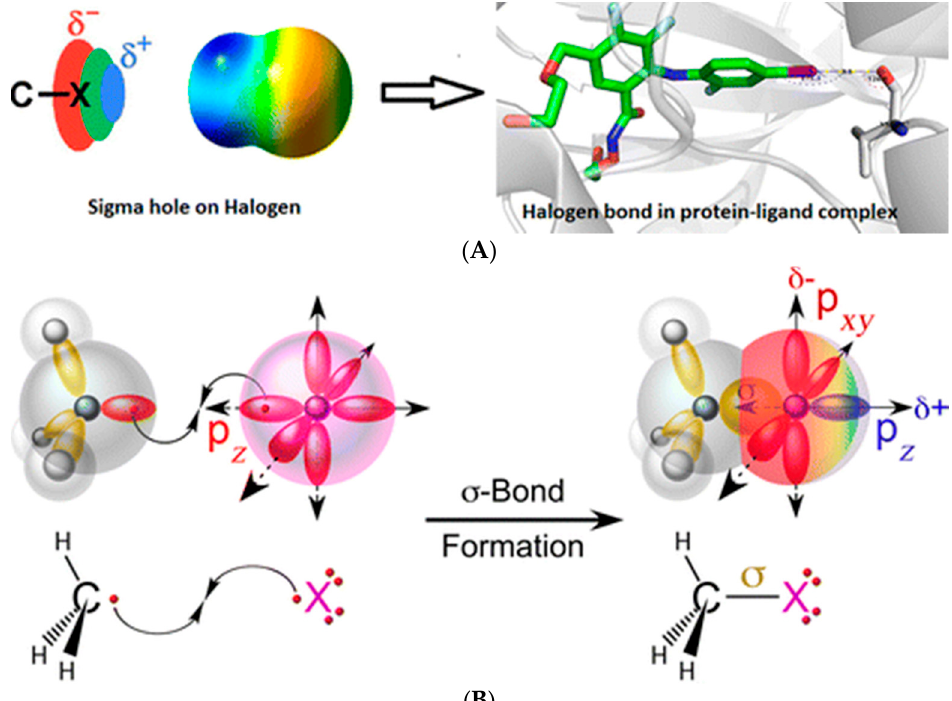
Figure 1. ( A ) The appearance of a sigma-hole ( δ +) that can interact with a region of electron density residing in a different atom. Here, the halogen atom (or R-X) is an “electron-poor” species and acts a halogen-bond donor (D). The acceptor (Y) possesses a rich electron density and acts as a nucleophile, thereby completing the halogen bond between the Donor sigma-hole and the acceptor lone pair. Such an interaction is observed in many drug:receptor systems. ( B ) Another view detailing the formation of the σ -hole: The covalent bond (C-X) between the Carbon atom and the halogen ( σ -bond, yellow) pairs an electron from the carbon with one from the valence p z -orbital of the halogen. The electron withdrawing nature of the R-C moiety results in the depopulation of the p z -orbital of the halogen atom. As a result, it creates an electropositive crown (blue) and flattening of the atomic radius opposite the σ -bond, while the p x,y -orbitals remain fully occupied, resulting in an electronegative annulus perpendicular to the covalent bond. [Figure (1A) has been reproduced with permission from reference [39] and (1B) from reference [15].